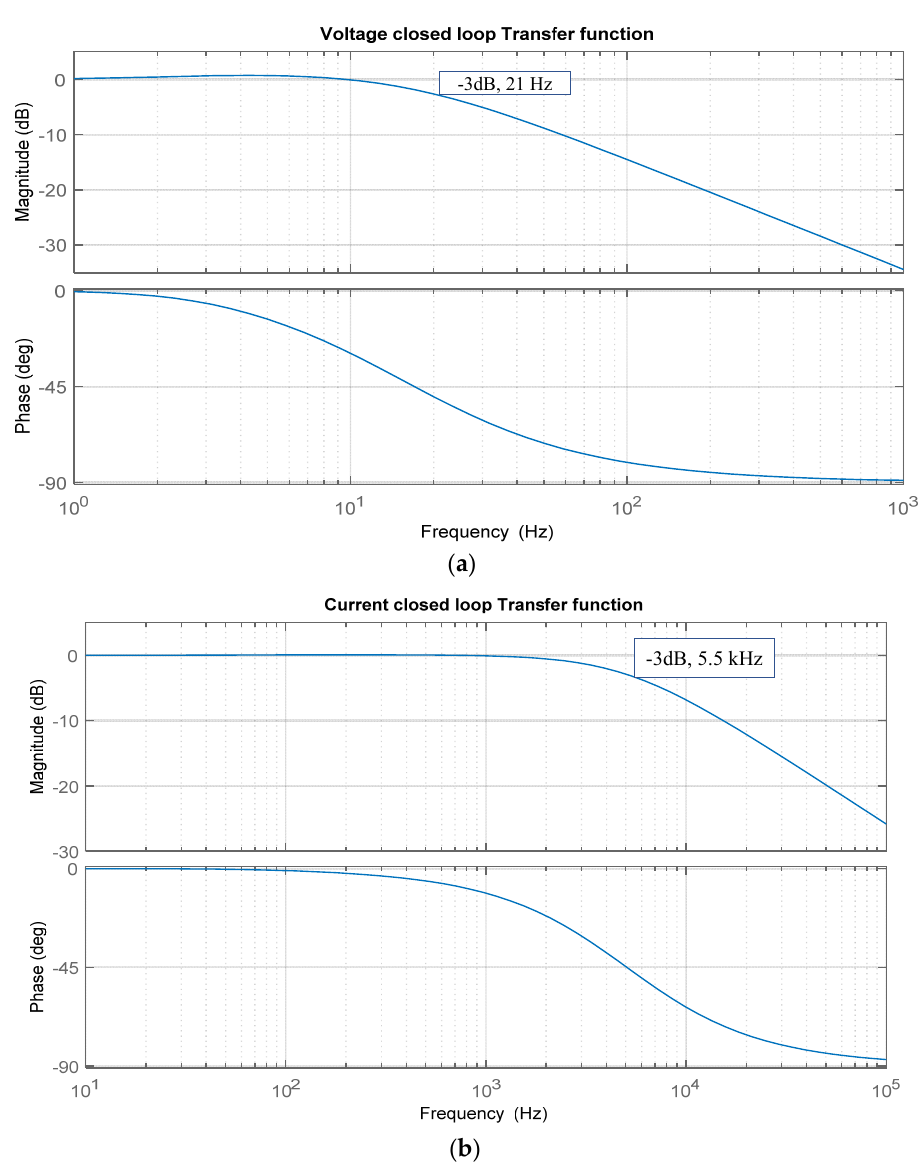
Figure 11. Implementation technique of the interleaved CCM PFC analog control circuit.